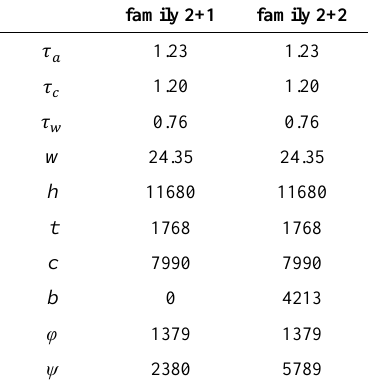
Table 1. The values of parameters